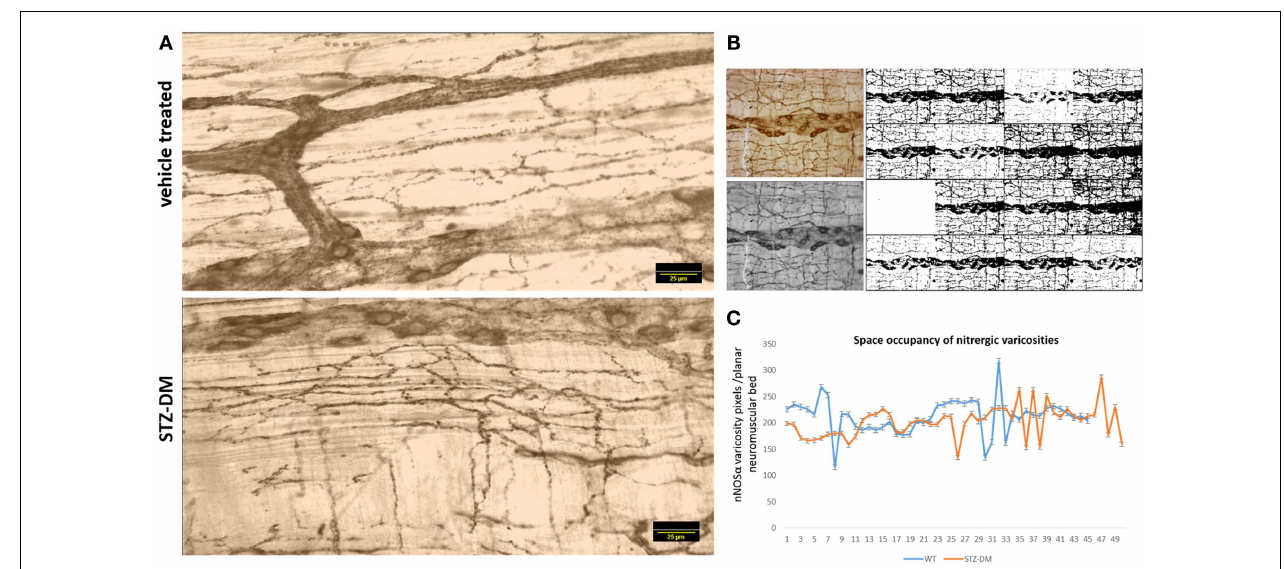
FIGURE 9 | Comparable levels of ramifications of nitrergic axonal processes and varicosities on the muscularis of vehicle treated